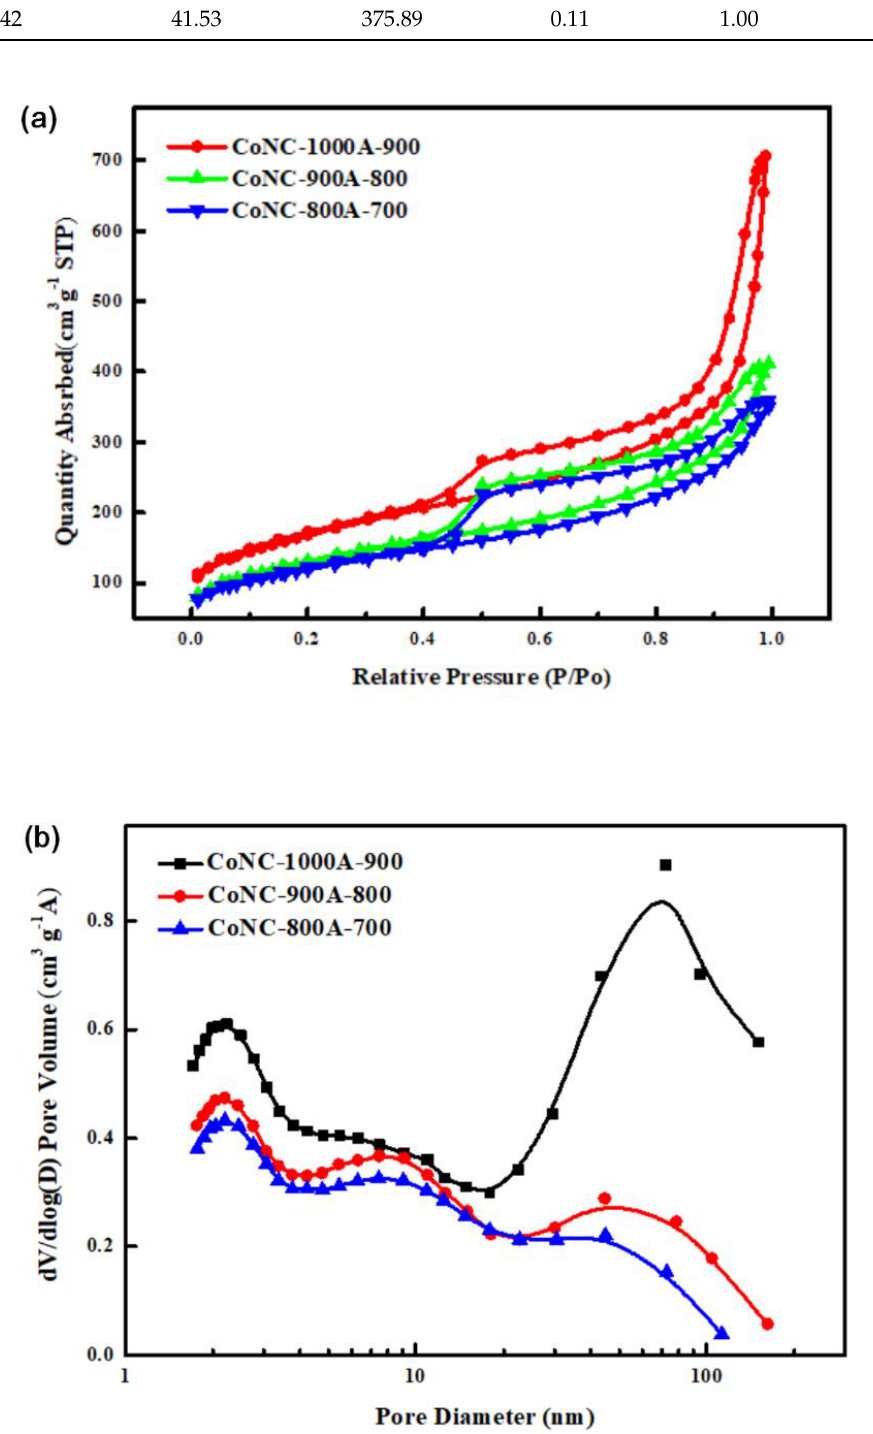
Figure 7. ( a ) BET isothermal adsorption and desorption curves; ( b ) pore volume vs. size of Co-N-Cs treated with different two-stage calcinations .